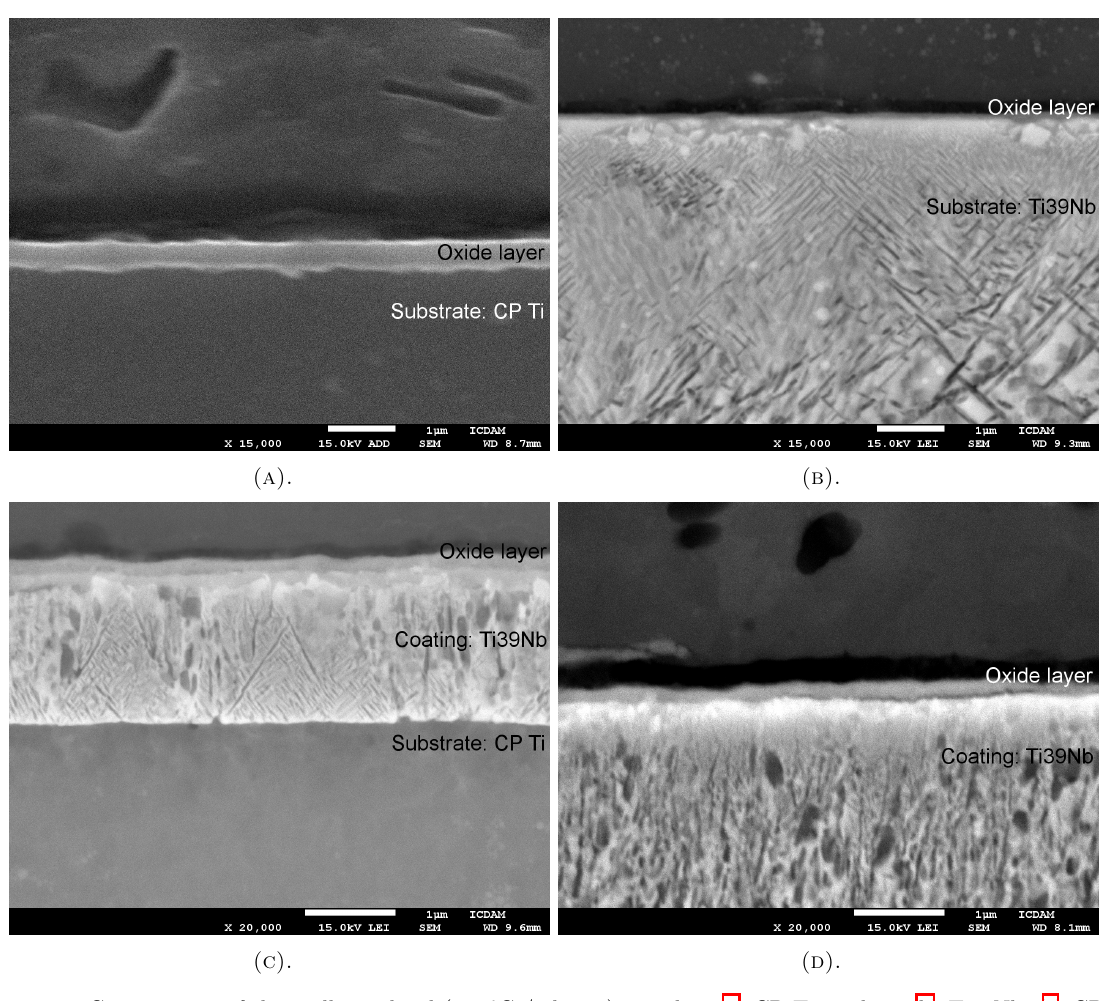
Figure 1. Cross-section of thermally oxidized (600 °C /8 hours) samples: (a) CP Ti grade 2, (b) Ti39Nb, (c) CP Ti grade 2 + 2 µm of Ti39Nb, (d) CP Ti grade 2 + 5 µm of